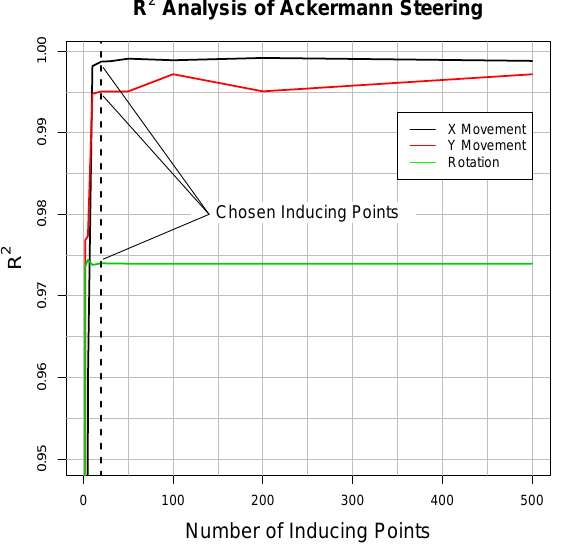
Figure 7. Visualization of the R 2 values of the sGP model